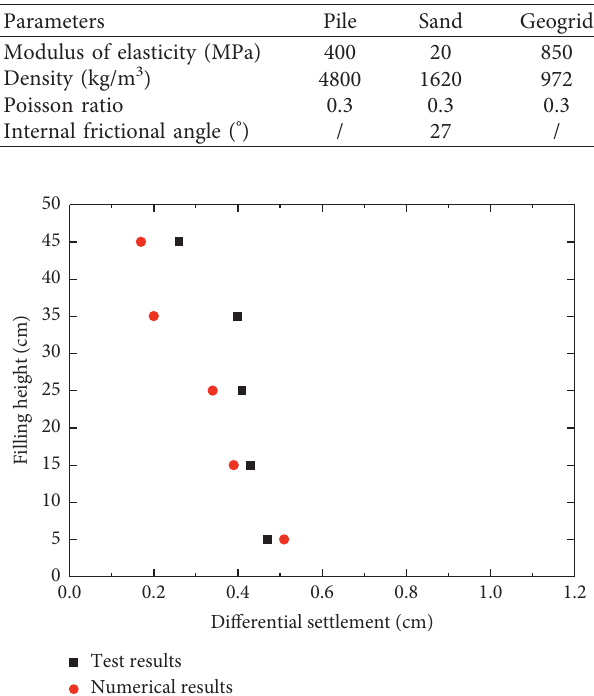
Figure 9: Meshing of the numerical model. Table 3: Mechanical parameters for the numerical model.